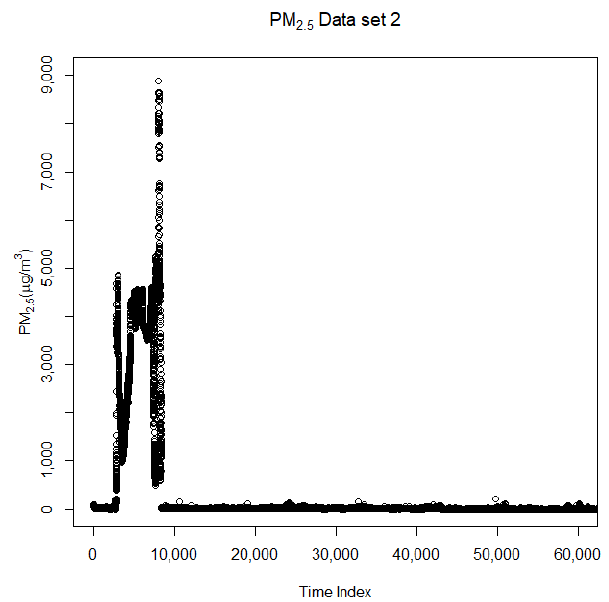
Figure 6. This is Dataset 2, collected for 8 days between 25 January 2019 and 1 February 2019. The length of the dataset is 62,878, having 74 missing datapoints in